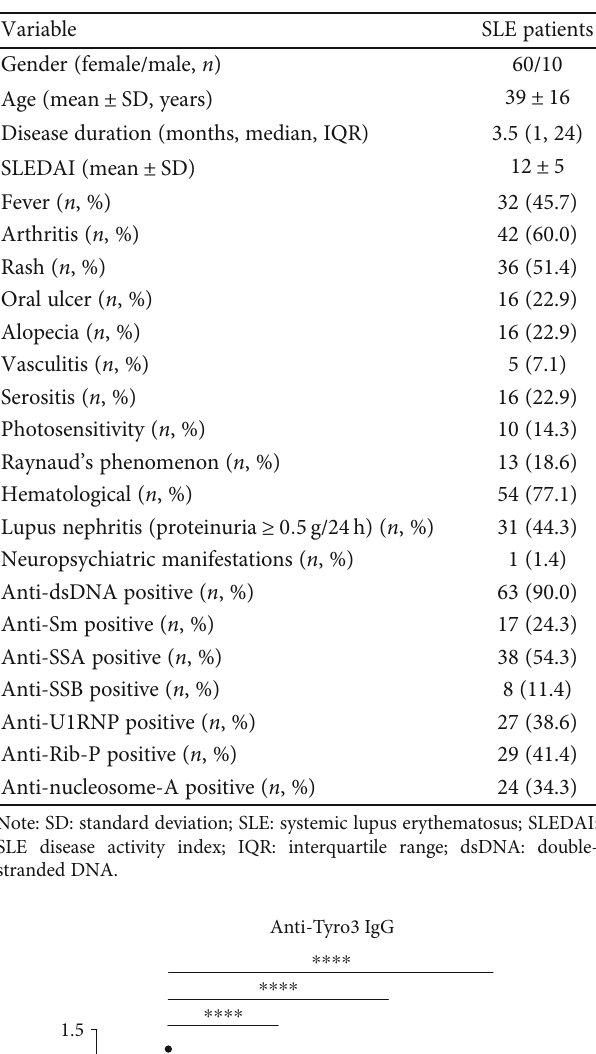
Table 1: The clinical and laboratory characteristics of new-onset and treatment-naïve SLE patients.